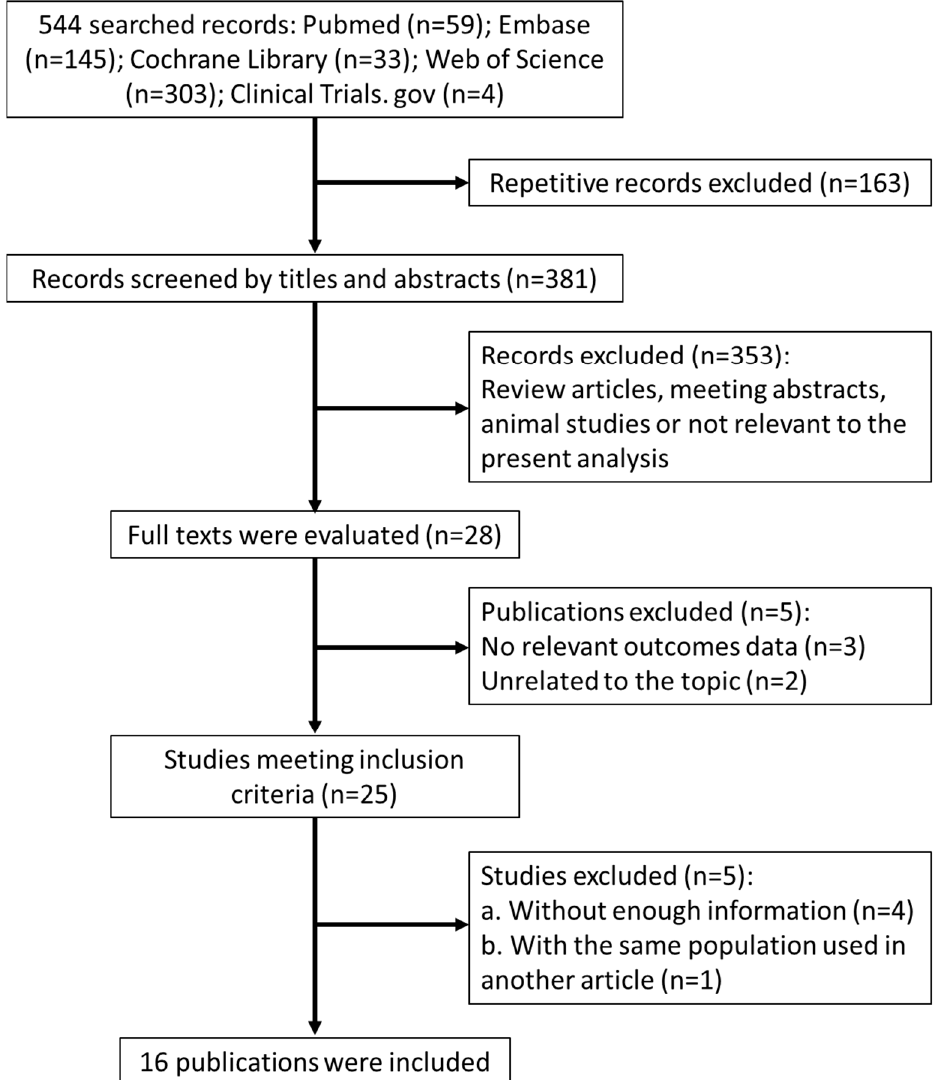
Figure 1. Flow diagram of the study selection.